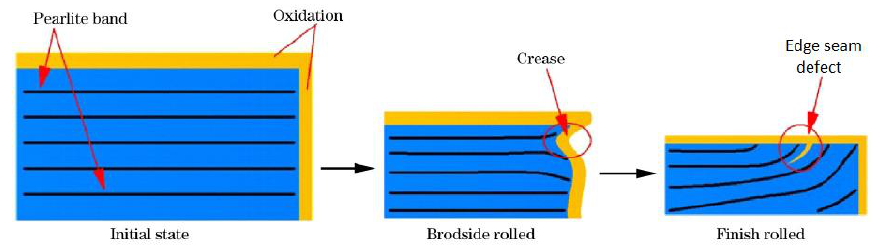
Figure 2. Formation and inversion of edge creases.